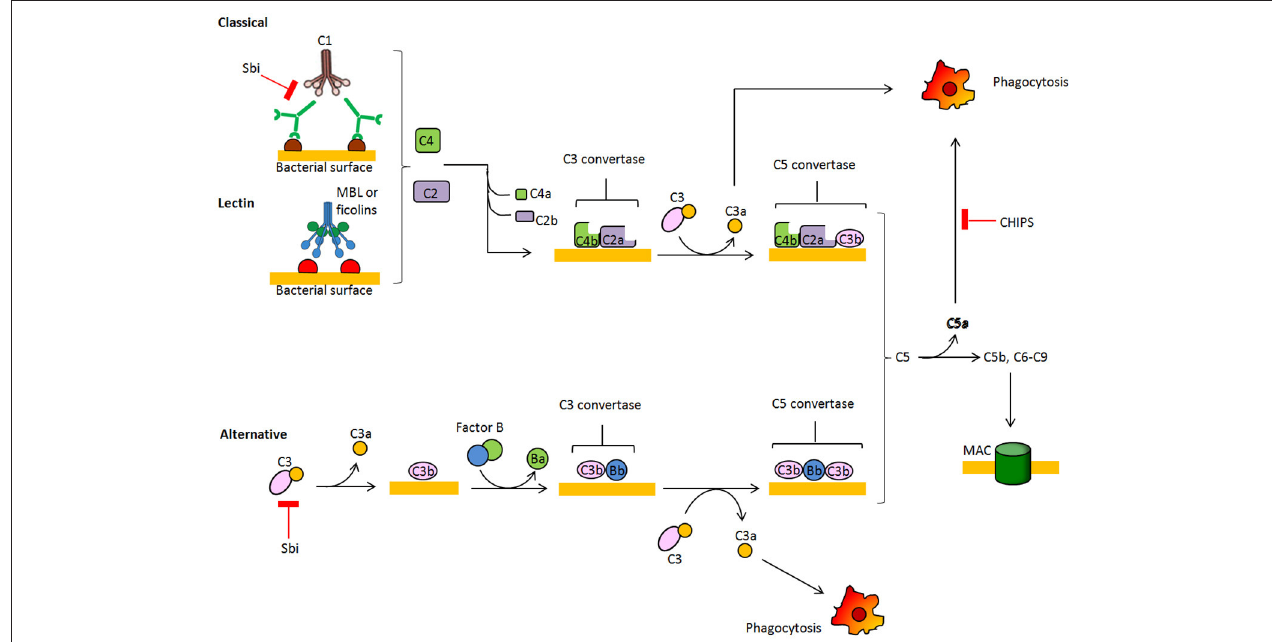
FIGURE 2 | Schematic overview of the complement system. The complement cascade is activated by recognition of microbe-bound antibodies or bacterial sugars by C1 complex (CP, classic pathway) or the MBL and ficolin MASP-2 complex (LP, lectin pathway), respectively. Both C1 and MASP-2 cleave C4 and C2 to generate a C4b2a complex on the bacterial surface. This complex is a C3 convertase that cleaves C3 into C3a and C3b, which binds covalently to the bacterial surface. The alternative pathway (AP) C3 convertase C3bBb is generated after binding factor B to surface bound C3b and subsequent cleavage by factor D. C3b molecules also generate C5 convertases C4bC2aC3b and C3bBbC3b by binding near to C3 convertases. C5 convertases cleave C5 into soluble C5a, which attracts neutrophils to the site of infection, and C5b which forms a complex with C6-9 proteins to generate the membrane attachment